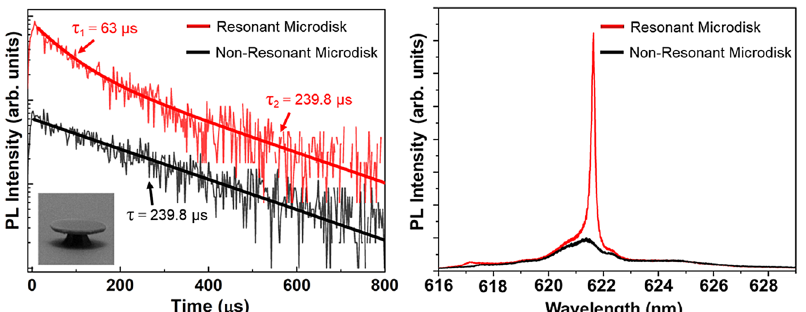
Figure 15: (Left) Photoluminescence (PL) decay spectra for Eu-doped GaN samples with different microdisks structures. The nonresonant microdisk exhibited a single exponential fit with a lifetime consistent with that of a bulk Eu-doped GaN samples (239.8 μ s). The resonant microdisk exhibited a biexponential decay with a fast component of ∼ 63 μ s and a slow component of 239.8 μ s, indicating that the 5 D 0 state decay rate of Eu 3 + ions that had coupled to the cavity modes increased by a factor of four. The inset shows a scanning electron microscope image of an Eu-doped GaN microdisk. (Right) PL emission from the resonant and